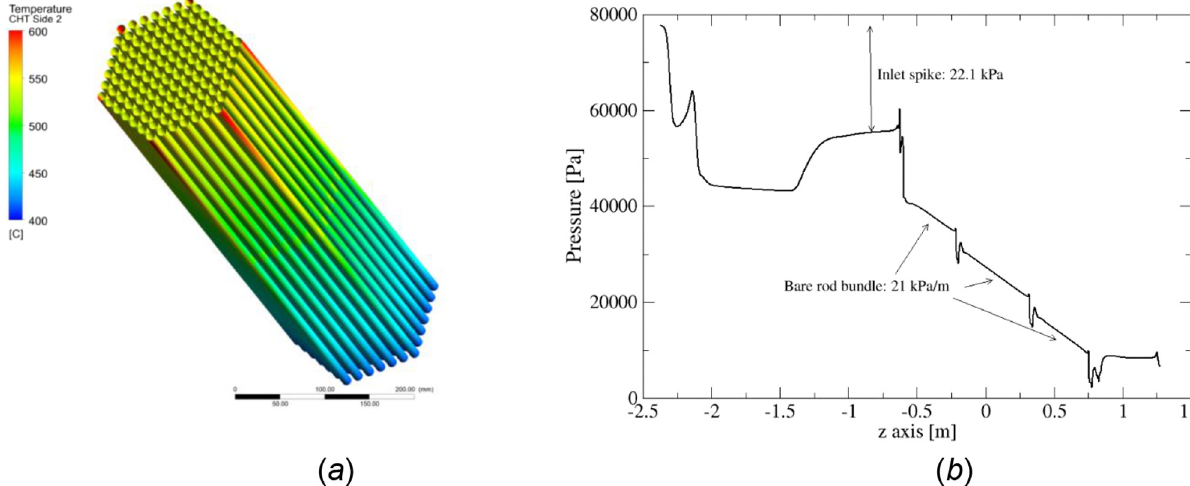
Fig. 4. Clad temperature distribution (a) and cross-section averaged pressure distribution along the streamwise direction (b): unperturbed case (ALFRED fuel